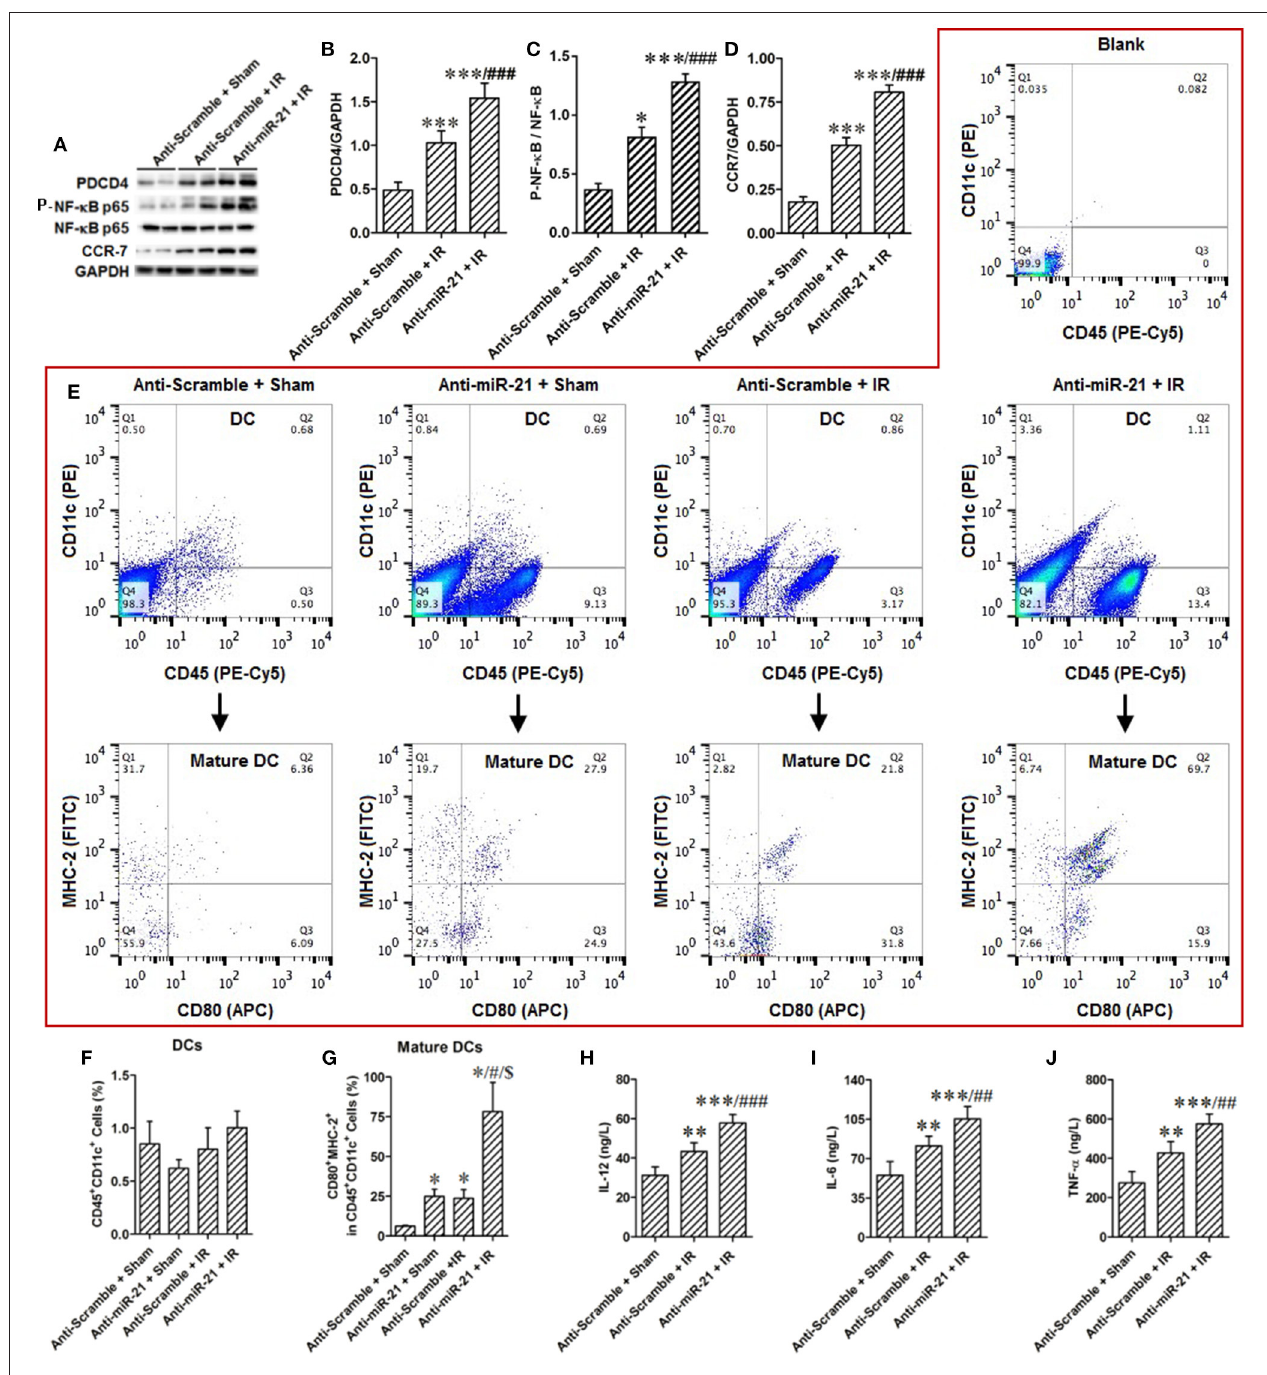
FIGURE 3 | Knockdown of miR-21 aggravate renal inflammatory response by promoting maturation of renal dendritic cells. (A–D) MiR-21 was inhibited by injection of LNA-modified anti-miR-21 before kidney IR surgery or sham operation. The effect of miR-21 on activation of PDCD4/NF- κ B/CCR-7 pathway that was essential in maturation of DCs was assessed in the IR treated kidney. IR activated PDCD4/NF- κ B/CCR-7 pathway, and knockdown of miR-21 further elevated IR-inducible PDCD4/NF- κ B/CCR-7. ** P < 0.01, *** < 0.001, compared with Anti-scramble + Sham; ## P < 0.01, ### P < 0.001, compared with Anti-scramble + IR, n = 6. (E) The percentage of DCs or mature DCs in the single cell suspensions of the kidney was measured by flow cytometry. Either knockdown of miR-21 or IR promoted maturation of DCs, but not alter the filtration of total DCs. Moreover, knockdown of miR-21 further aggravated IR-induced maturation of DCs. (F,G) Group data from (E) . * P < 0.05, compared with Anti-scramble + Sham; # P < 0.05, compared with Anti-miR-21 + Sham; $ P < 0.05, compared with Anti-scramble + IR, n = 3. (H–J) The produce of proinflammatory factors IL-12, IL-6, TNF- α which were secreted from mature DCs was assessed by ELISA. As expected, IR increased and knockdown of miR-21 further raised their content. ** P < 0.01, *** < 0.001, compared with Anti-scramble + Sham; ## P < 0.01, ### P < 0.001, compared with Anti-scramble + IR, n = 6.